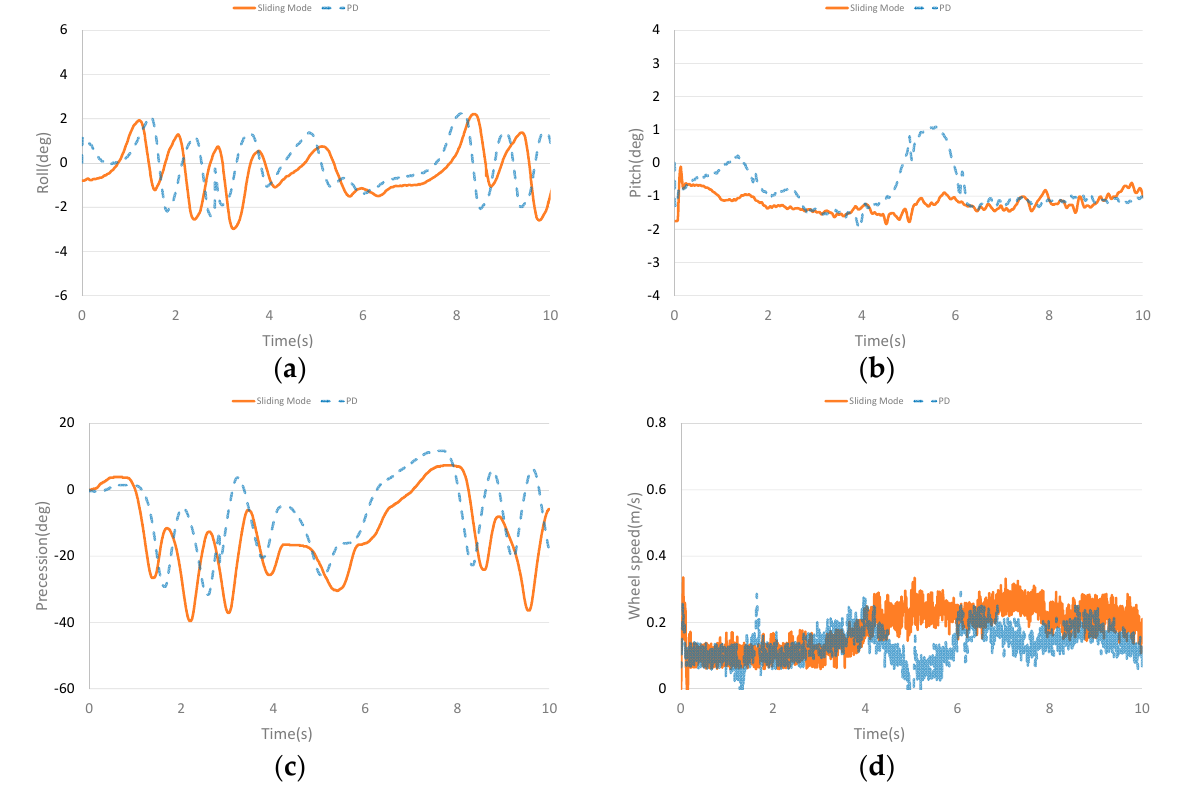
Figure 7. Dynamic balance curves. ( a ) The roll angle curve in dynamic balance experiment. ( b ) The pitch angle curve in dynamic balance experiment. ( c ) The precession angle curve in dynamic balance experiment. ( d ) The speed curve in dynamic balance experiment.